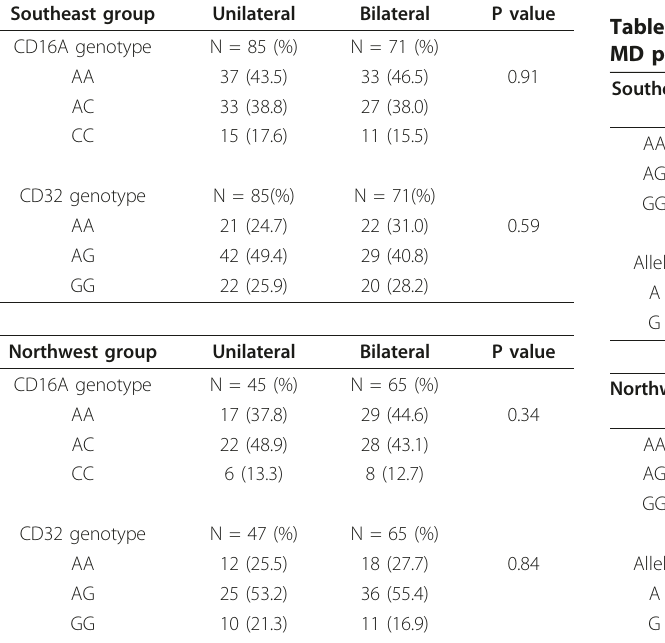
Table 3 Distribution of CD16a and CD32 genotypes in patients with uni and bilateral MD ( c 2 test) Southeast group